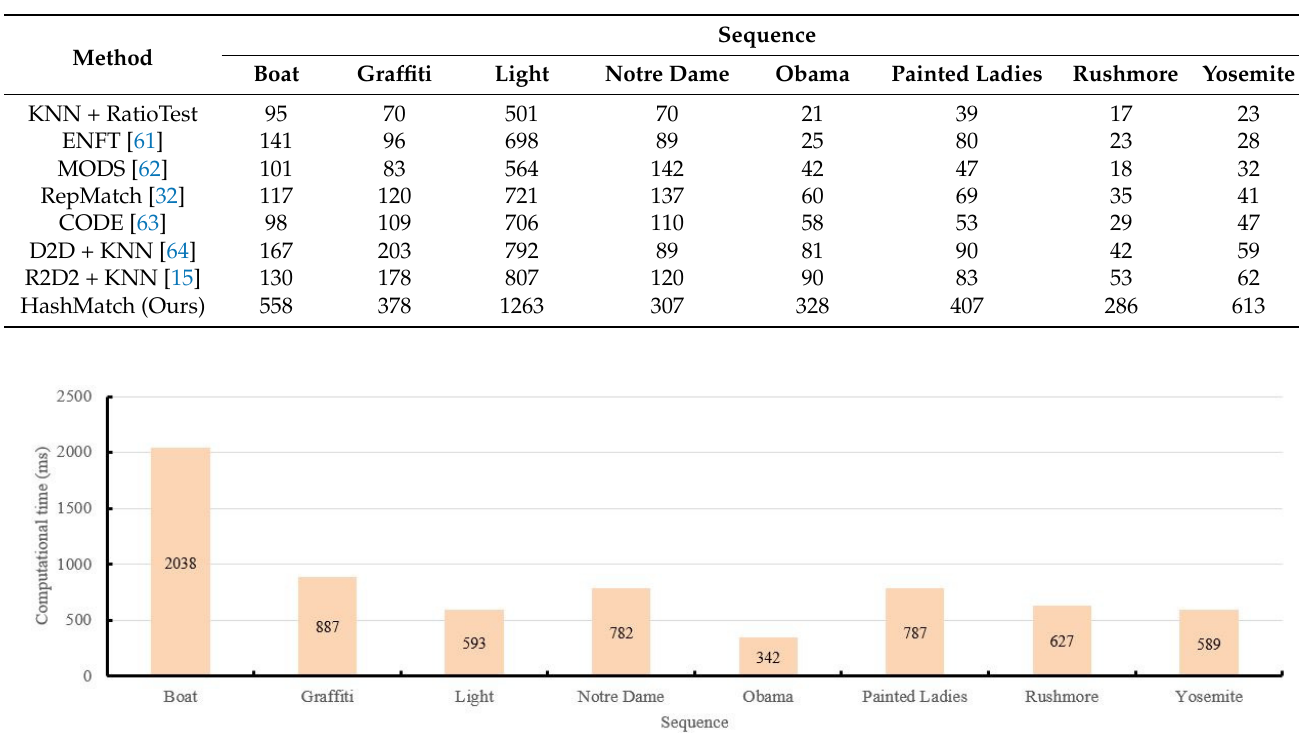
Figure 6. Matching results for Image pairs from the EdgeFoci dataset. Table 1. Statistical results (correct matches) of the EdgeFoci dataset.